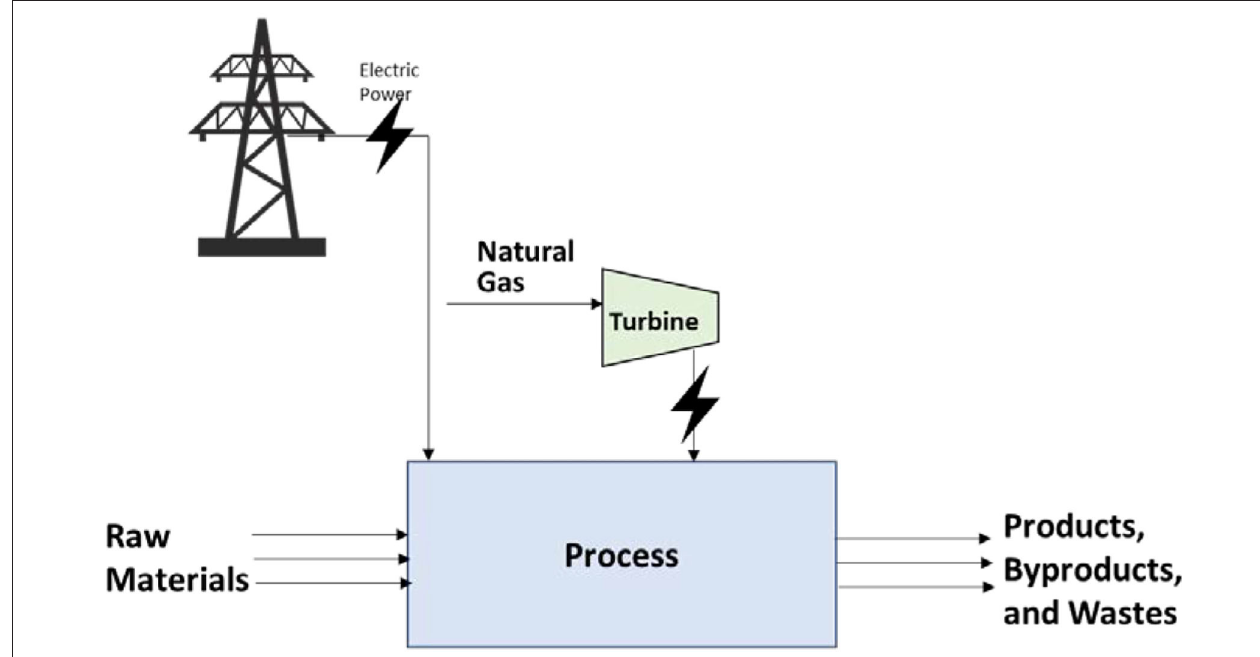
FIGURE 3 | Redundancy through an alternate/supplementary/emergency power generation